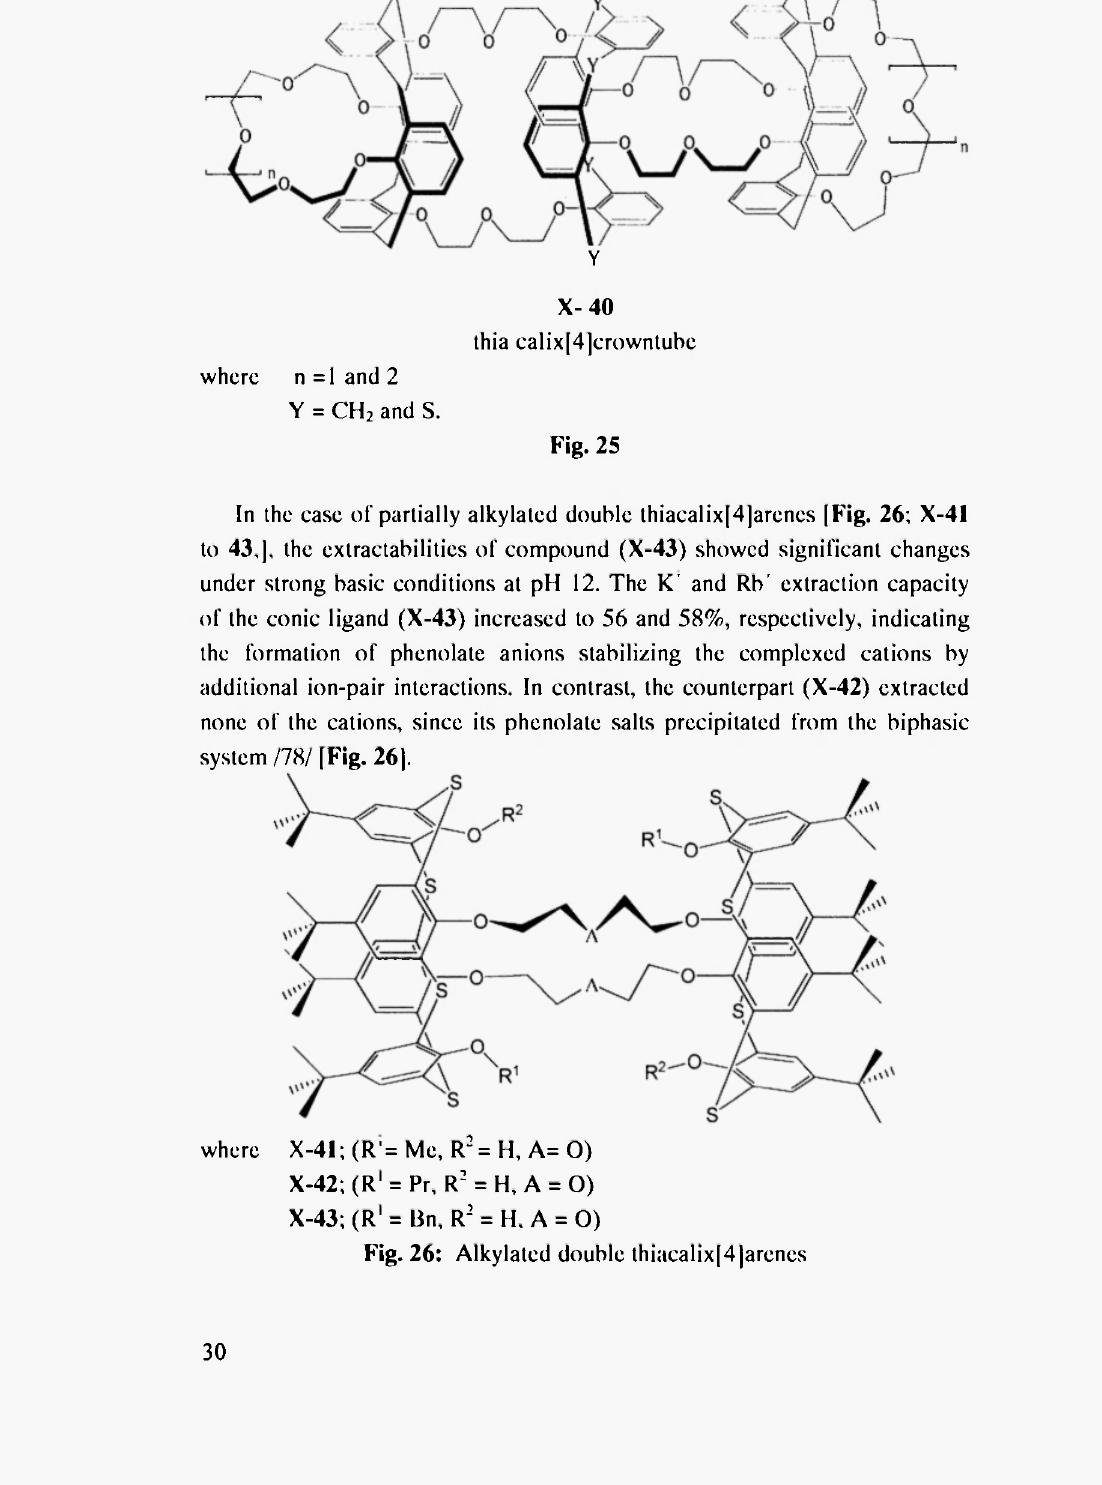
Fig. 26: Alkylated double